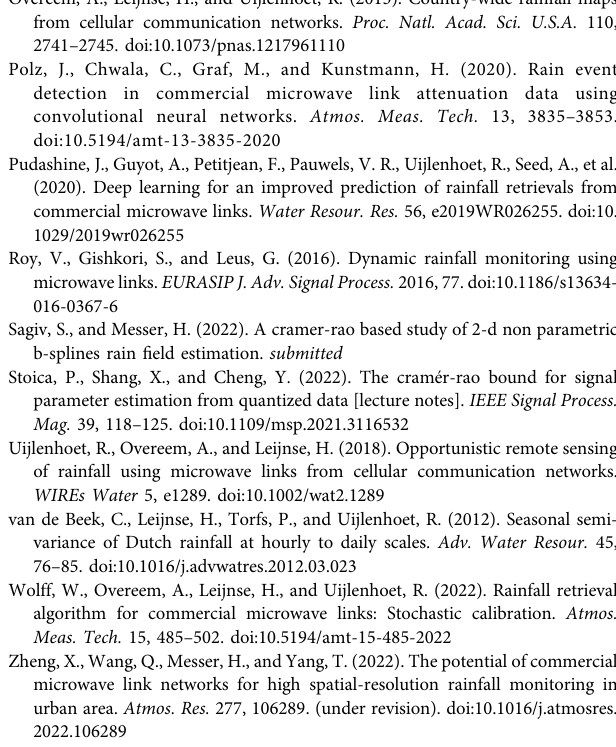
algorithm for commercial microwave links: Stochastic calibration. Atmos. Meas. Tech. 15, 485 – 502.